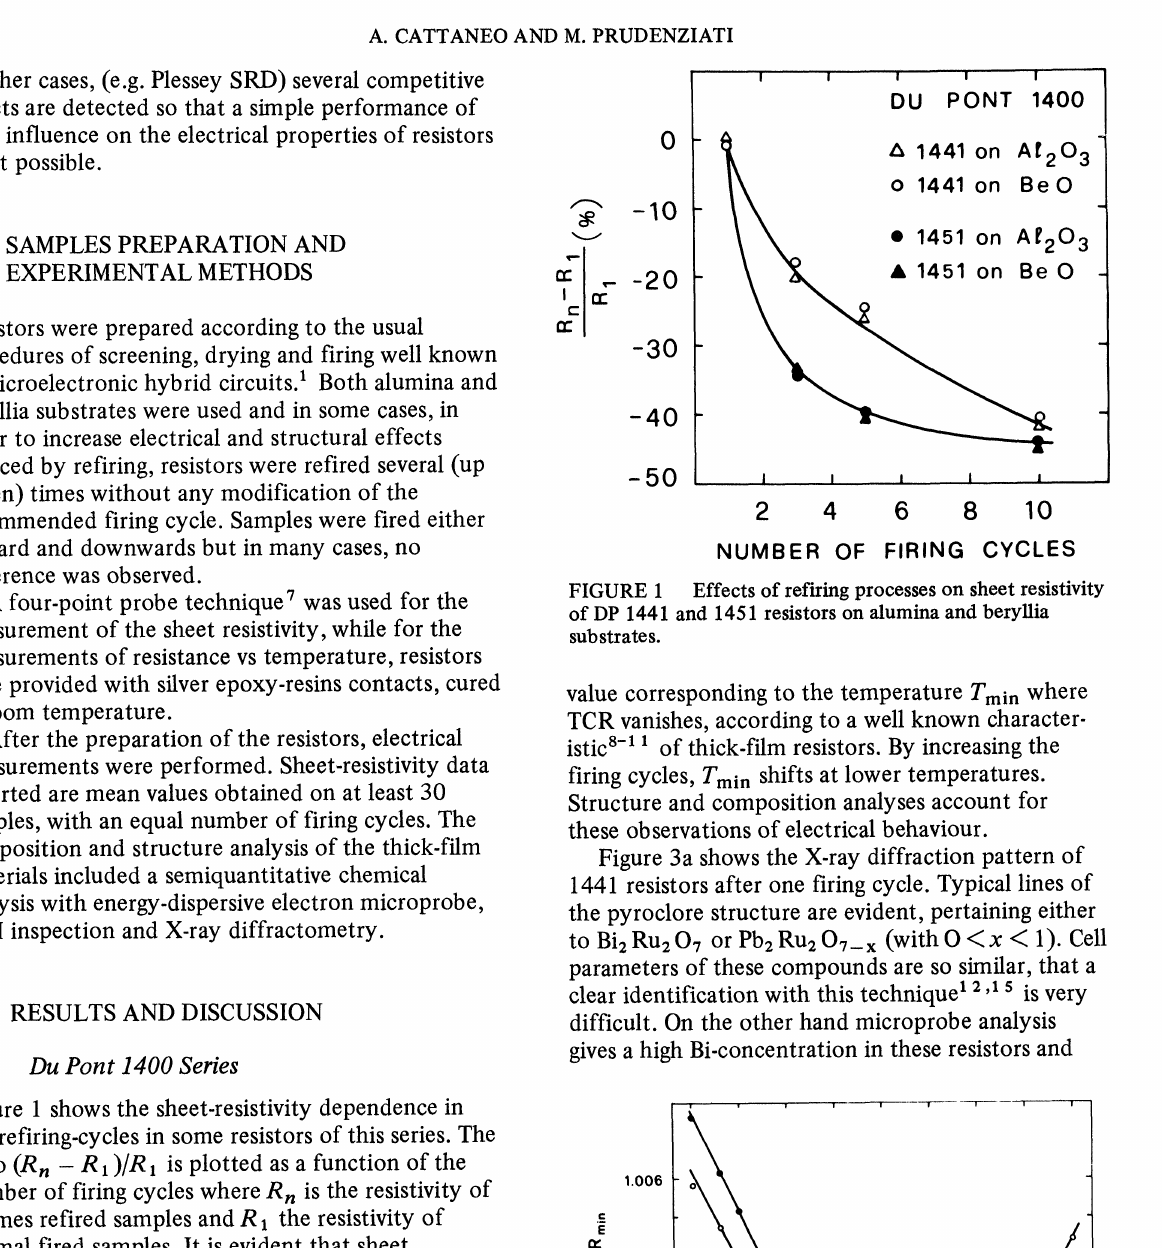
Temperature-dependence of resistance in DP 1441 resistors on alumina after and 10 firing